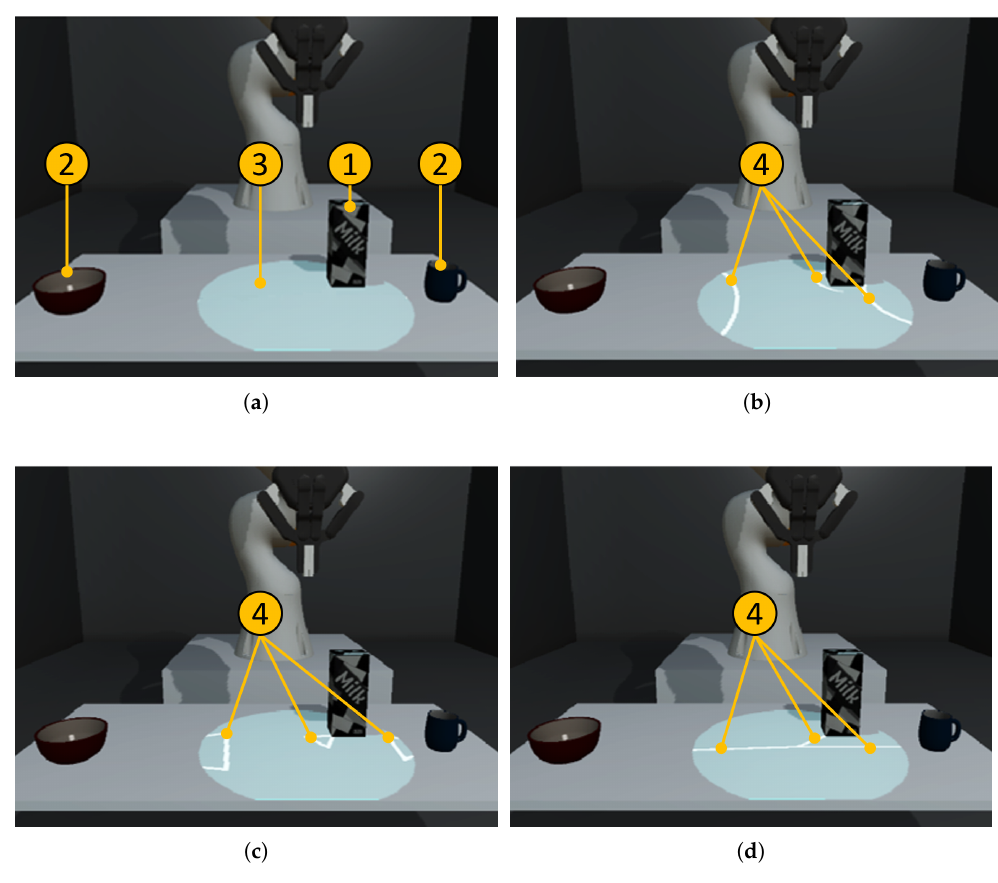
Figure 4. A detailed overview of ( a ) the setup highlights the different parts as (1) on-screen object; (2) off-screen object; and (3) the projection area. The (4) main features are highlighted for the selected visualization techniques ( b ) Halo , ( c ) Wedge , and ( d ) Line